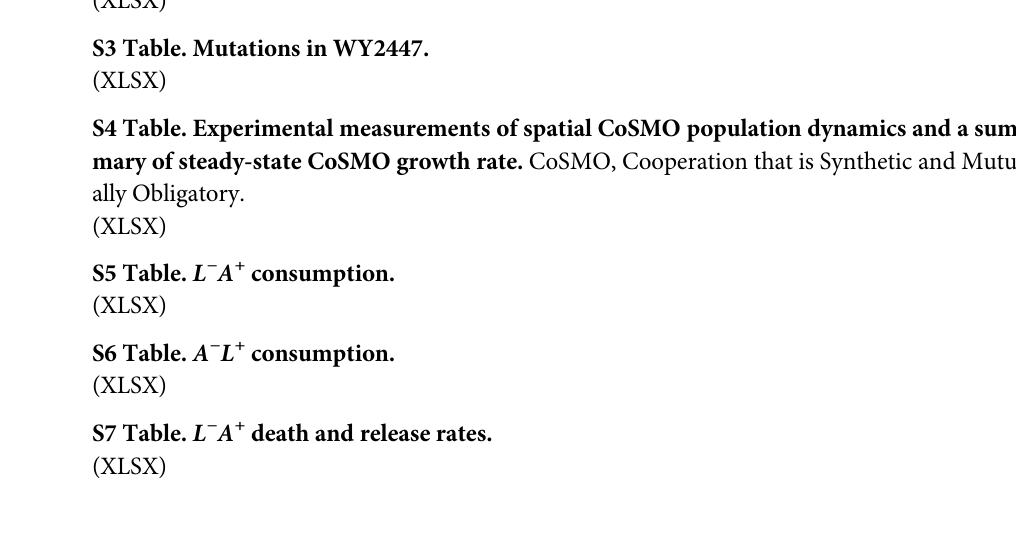
S1 Table. Strain table. S2 Table. Parameters for models i and ii, corresponding to Fig 1 and S1 Fig. CoSMO, Coop- eration that is Synthetic and Mutually Obligatory. S3 Table. Mutations in WY2447. S4 Table. Experimental measurements of spatial CoSMO population dynamics and a sum- mary of steady-state CoSMO growth rate. CoSMO, Cooperation that is Synthetic and Mutu- ally Obligatory. S5 Table. L − A + consumption. S6 Table. A − L + consumption. S7 Table. L − A + death and release